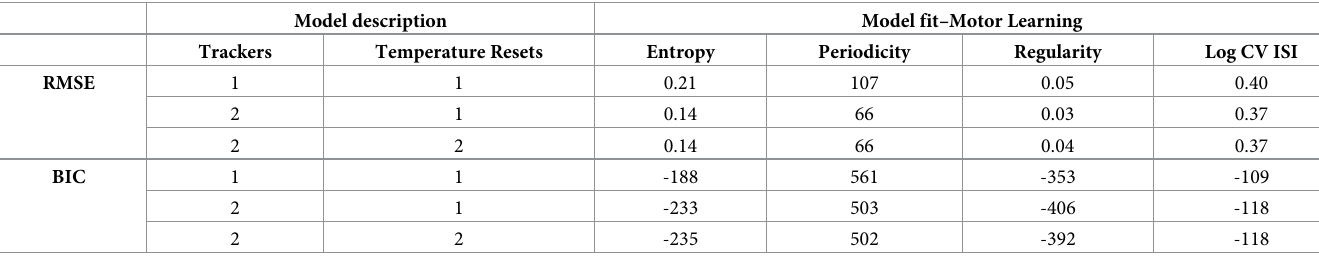
Table 4. Goodness of fit in terms of RMSE and BIC and model comparison across motor learning